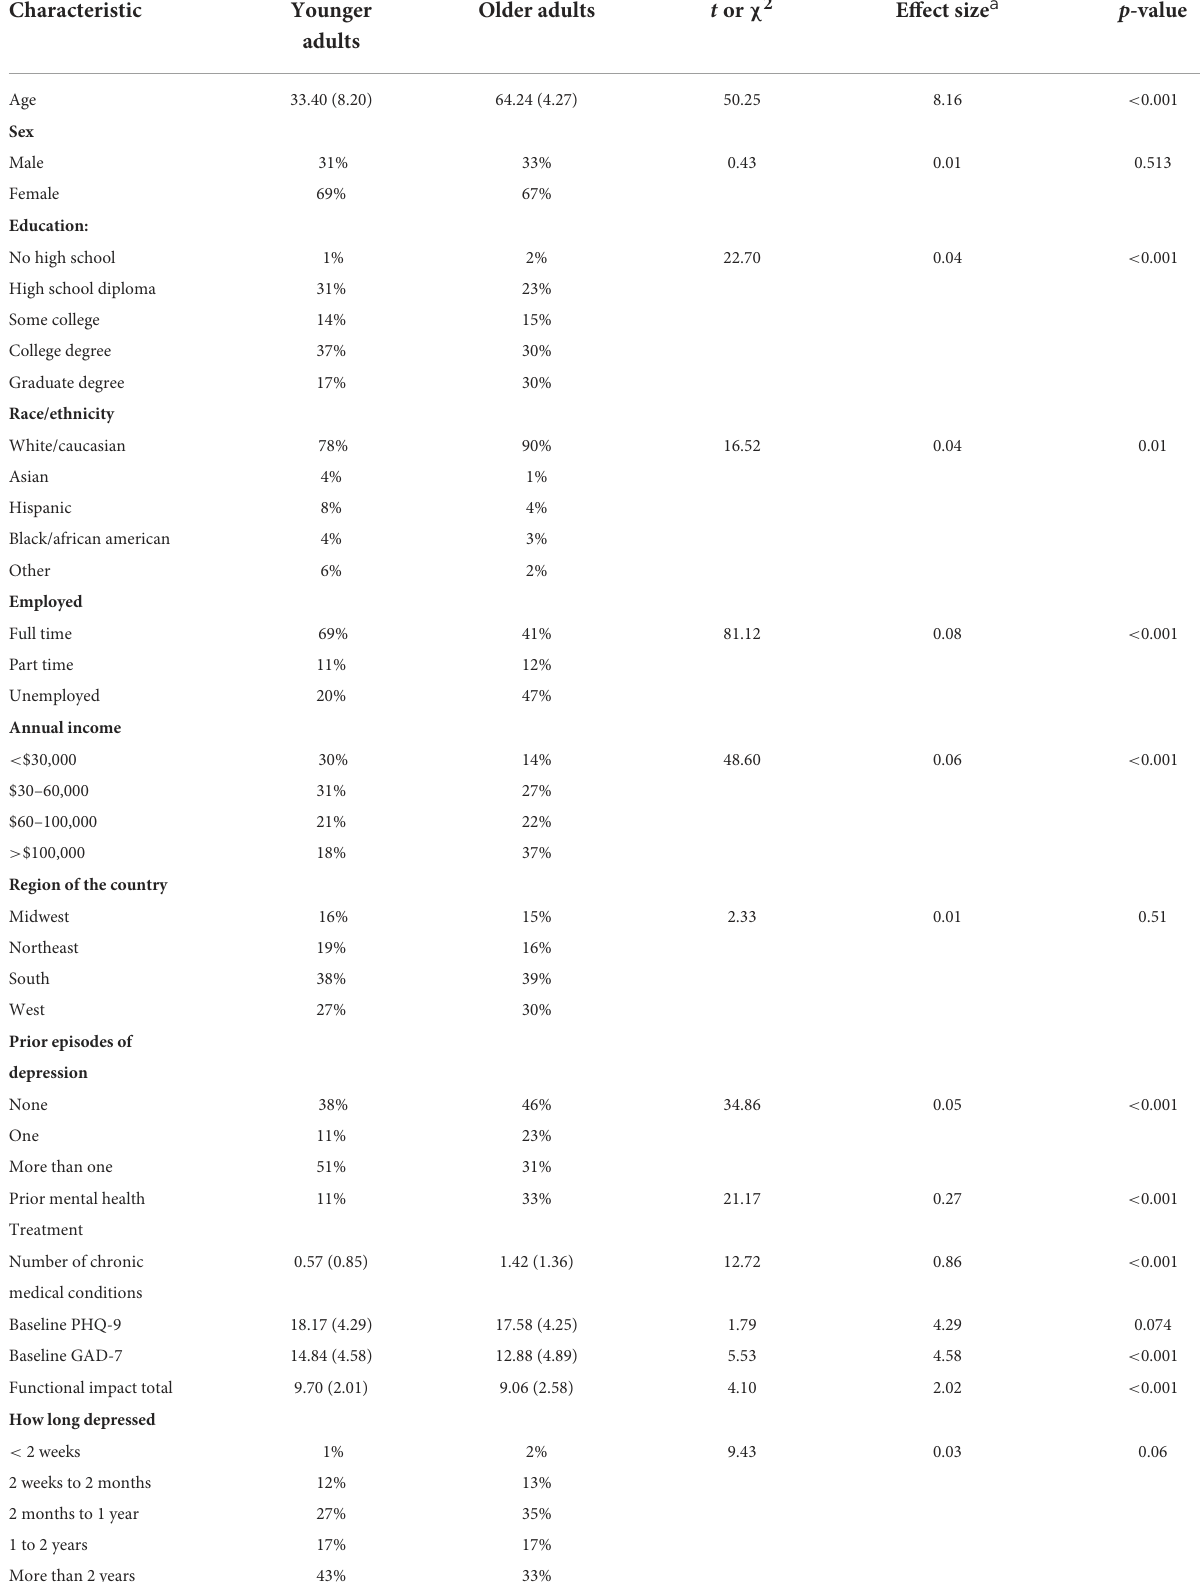
TABLE 1 Characteristics of younger and older adults, entire sample ( N = 12,908).